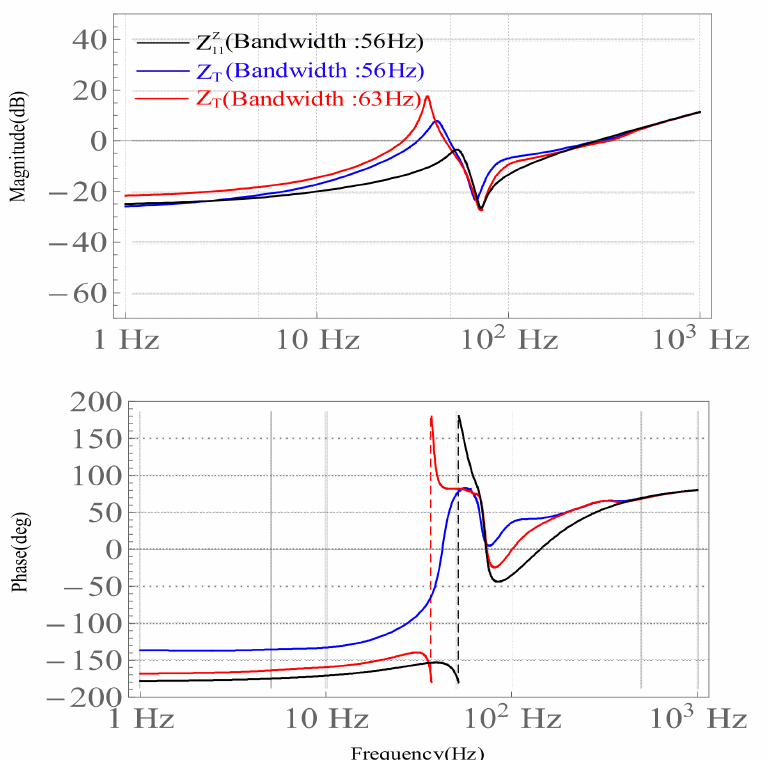
Figure 5. Impedance curves with different bandwidth of DC bus voltage control ( Z Z impedance of positive sequence perturbation without frequency coupling. Z T is the entire impedance of DFIG system considering the cross-coupling